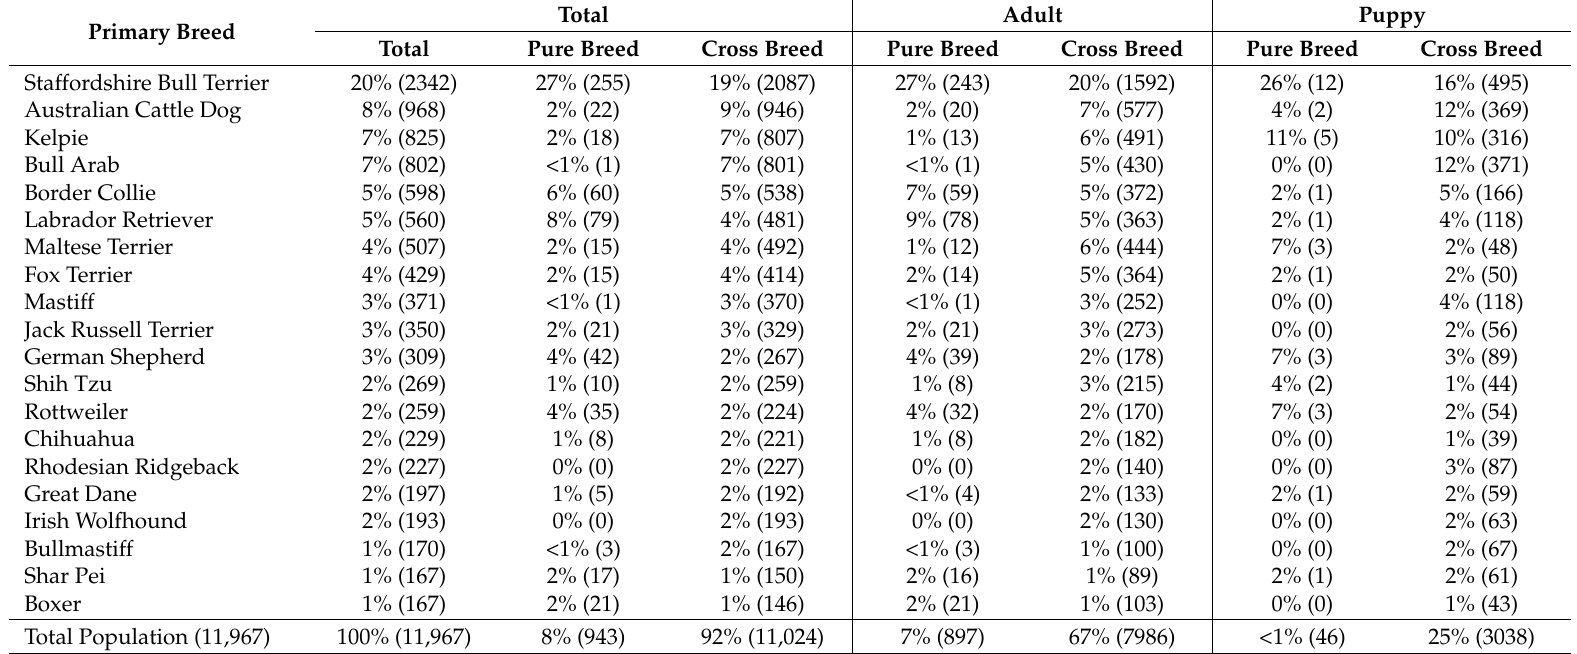
Table 4. Twenty most prevalent breeds of 11,967 dogs processed through RSPCA Queensland shelters in